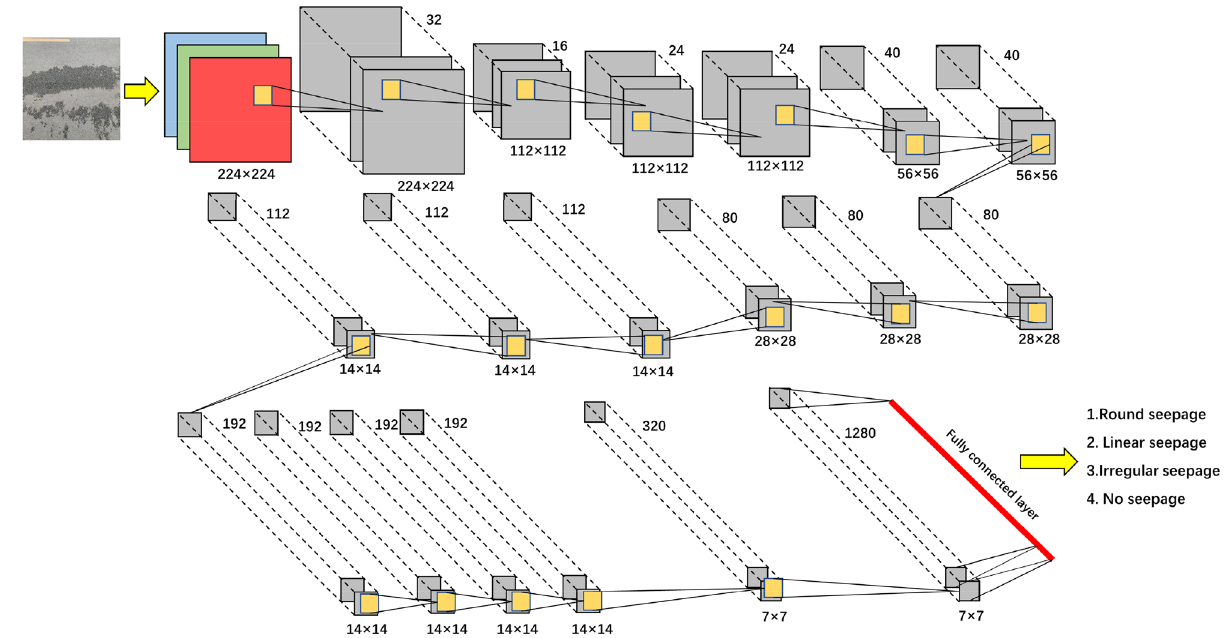
Figure 3. EfficientNet network structure.